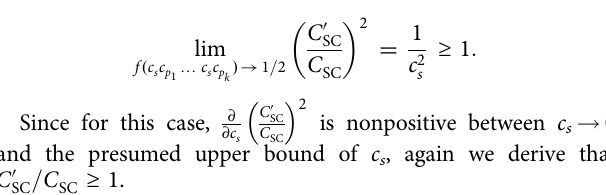
ffiffiffiffiffiffiffiffiffiffiffiffiffi